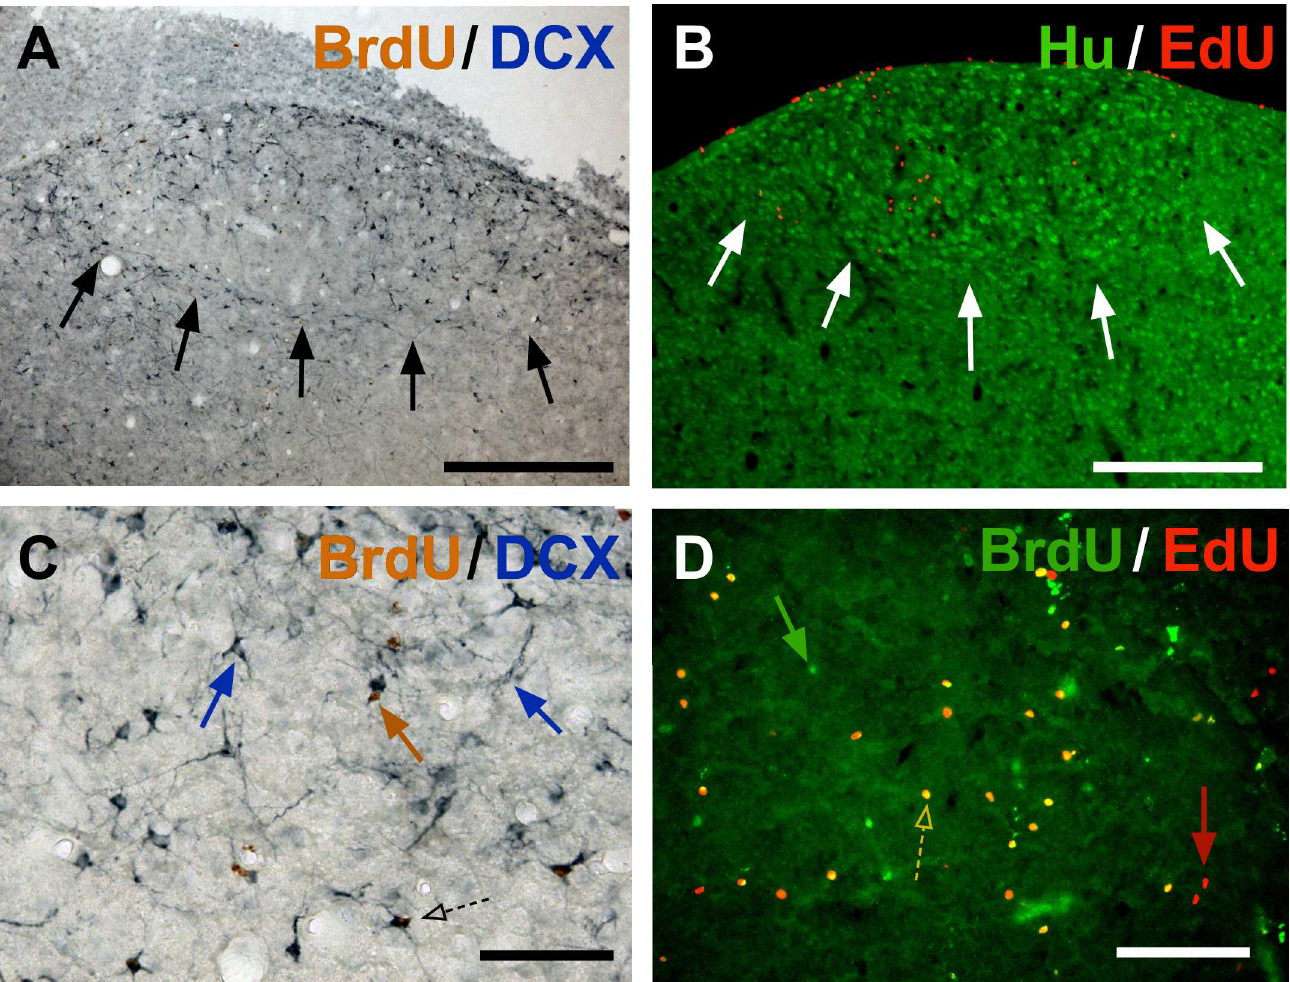
Fig 1. Photomicrographs illustrating the different labels used to identify new neurons in HVC at low (A-B) and high (C-D) magnifications. The first two panels show sectionsthrough the entire HVC that were stained for BrdU (brown) and DCX (blue; A) or with Hu (green) and EdU (red; B) illustrating the fact that these markers highlights the boundariesof HVC (arrows). Panel C shows at highermagnification a cell labeledfor BrdU only (brownarrow), two DCX-positive neuronsindicatedby blue arrows, one round (left) and one fusiform (right) in shape)and one DCX-positive neuron also containingBrdU in its nucleus(dotted arrow). Panel D illustratesthe doublelabel for BrdU and EdU with arrows pointingto cells labeledfor BrdU only (green), EdU only (red) and for both thymidineanalogs(dotted arrow). Magnification bars are 200 μ m in A-B and 50 μ m in